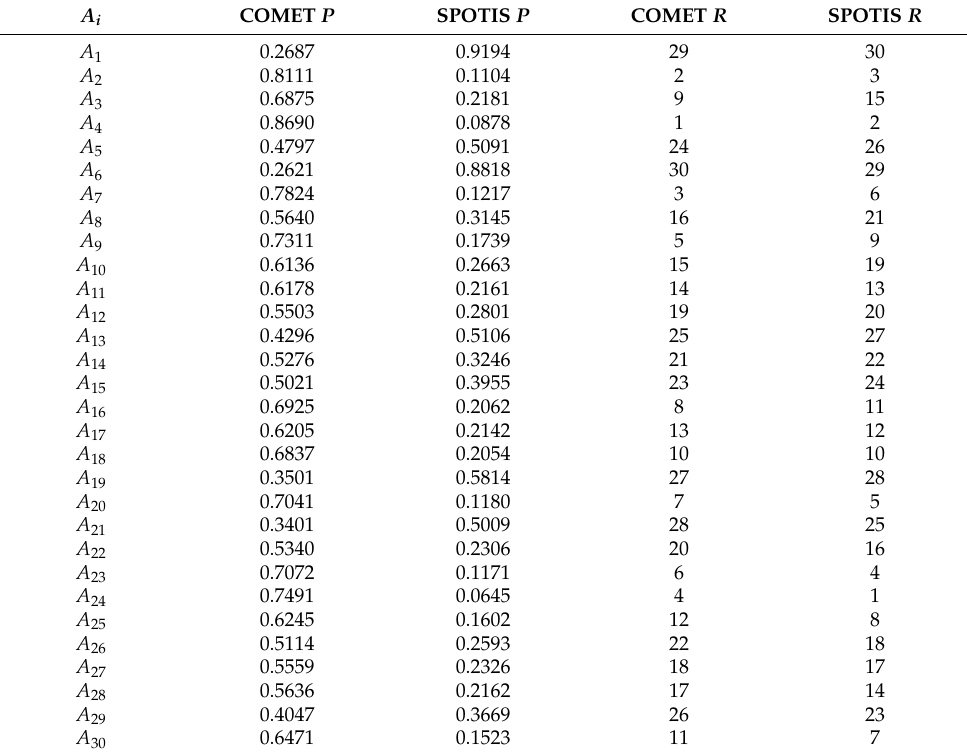
Table 4. Preference values and rankings obtained for evaluated alternatives with COMET and